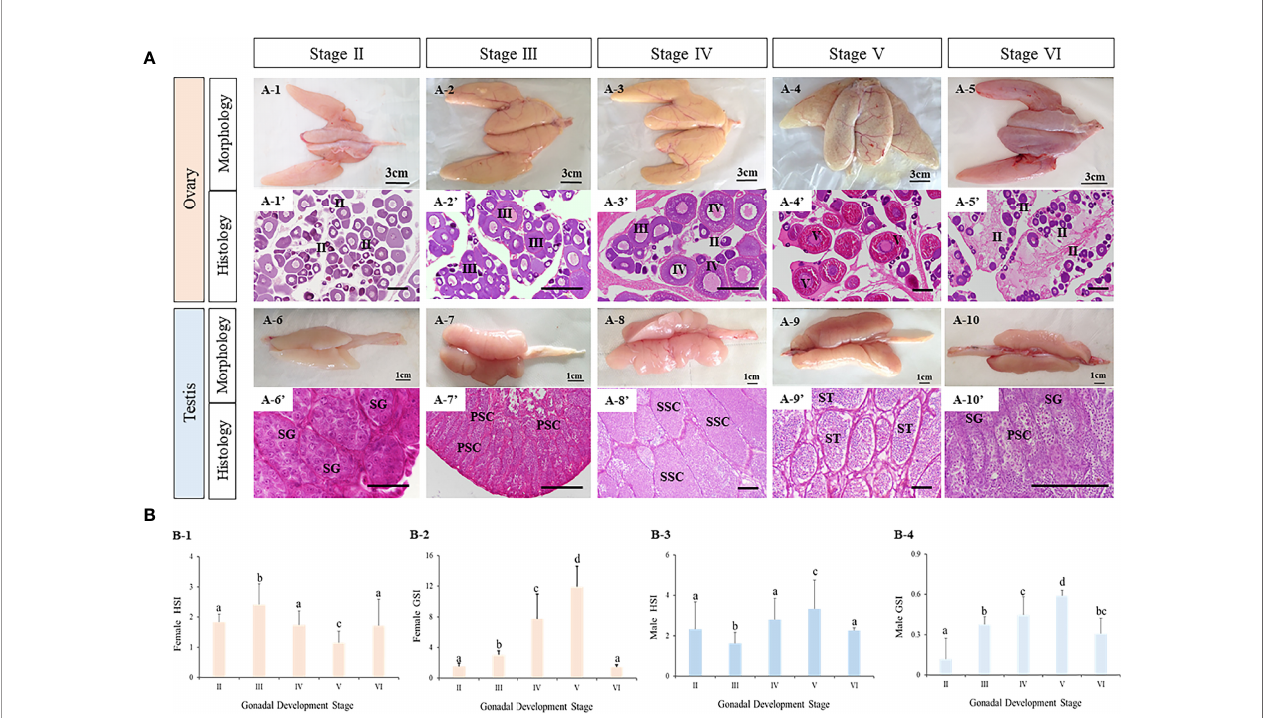
FIGURE 6 | The characteristics of tourbot testes and ovaries during reproductive cycle. (A) morphology and histology of turbot testes and ovaries. A1-5, morphology of turbot ovaries. A1 ’ -5 ’ , histology of turbot ovaries. A6-10, morphology of turbot testes. A6 ’ -10 ’ , histology of turbot testes. (B) GSI and HSI of turbot testes and ovaries. B1-2, GSI and HSI offemale turbot. B3-4, GSI and HSI of male turbot. (A) PSC, primary spermatocytes; SG, spermatogonia; SSC, secondary spermatocytes; ST, spermatids; SZ, spermatozoa; (B) I, previtellogenic oocytes. II, primary vitellogenic oocytes; III-IV, large growth of vitellogenic oocytes. Scale: A1-5, 3 cm; A6-10, 1 cm; A1 ’ -10 ’ , 50 m m. Different letters above bars represent statistical signi fi cance ( p < 0.05 ) at different reproductive stages in (B)